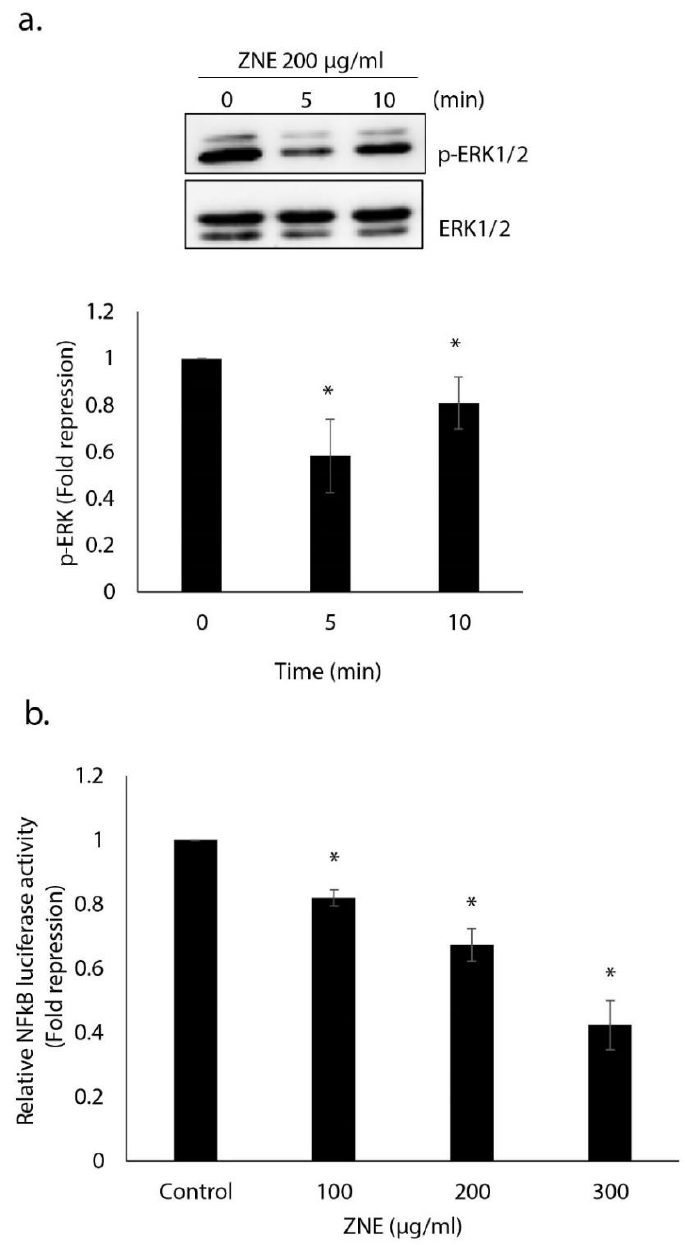
Figure 9. Ziziphus nummularia inhibits the ERK1/2 and NF κ B signaling pathways in pancreatic cancer cells. ( a ) Ziziphus nummularia downregulates the level of phosphorylated ERK1/2. Cells were treated without or with ZNE (200 µ g/mL) for 5 and 10 min, and protein lysates were examined for the level of phosphorylated ERK1/2. Data are representative of three independent experiments. ( b ) Ziziphus nummularia inhibits NF- κ B transcriptional activity. Capan-2 cells were transfected with the pGL4.32[luc2P/NF- κ B-RE/Hygro] expression plasmid, and luciferase activity was measured 18 h post-transfection as described in Materials and Methods. Data represent the means ± SEM of three independent experiments. * denotes p < 0.05.